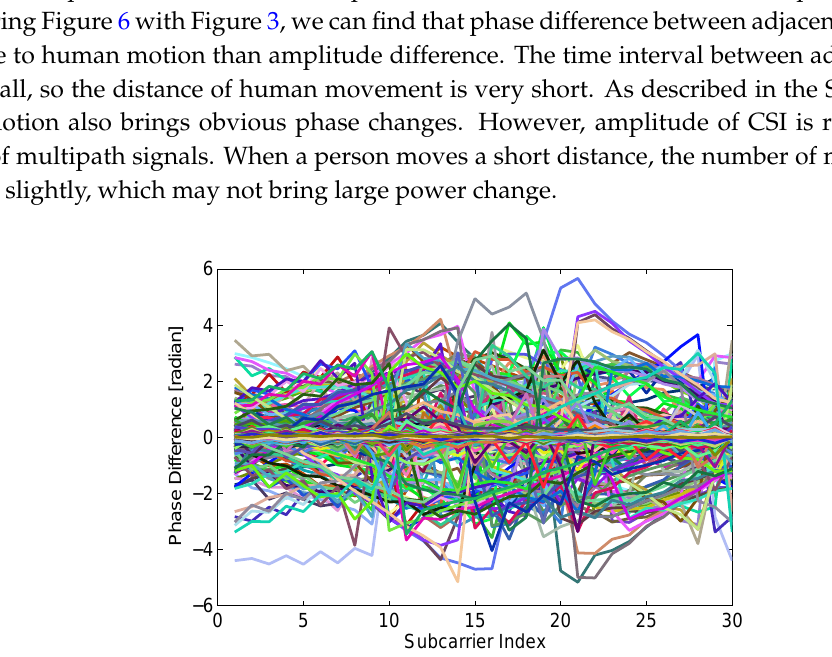
Figure 6. Phase differences between adjacent packets in the dynamic